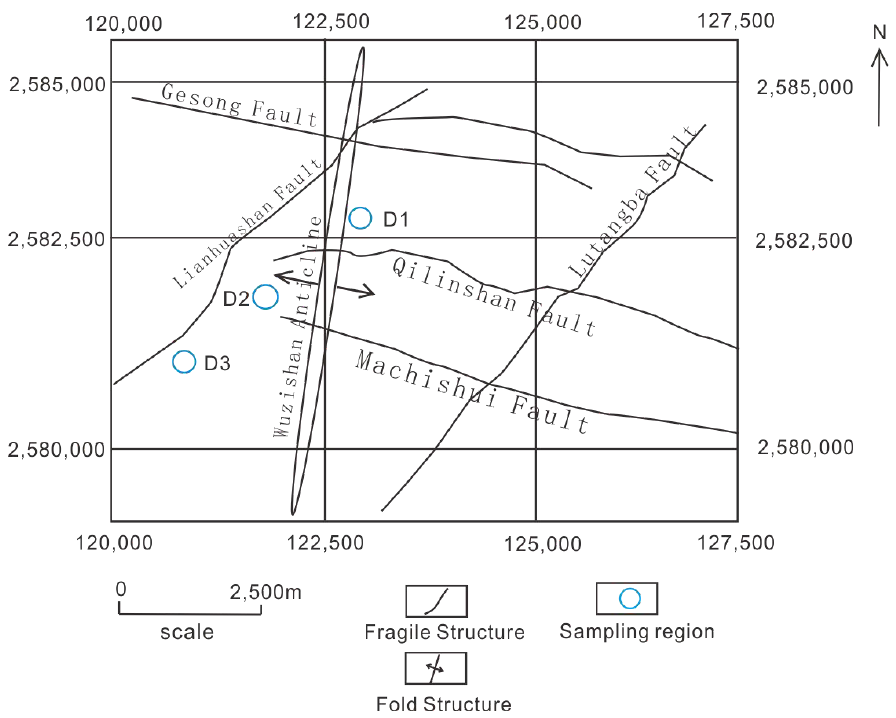
Figure 14. The sampling region in the study